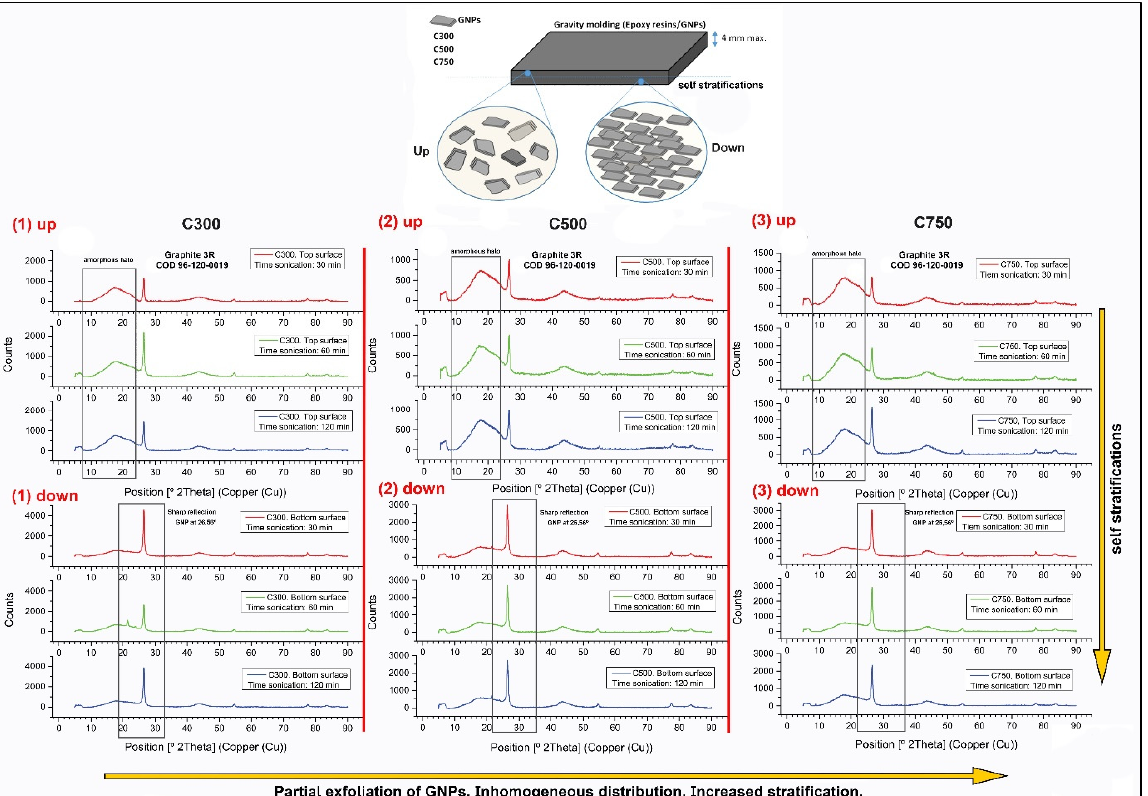
Figure 3. XRD diffraction pattern of GNP/epoxy composites. The spectra obtained are plotted according to the type of graphene used, C300 (1), C500 (2), and C750 (3), according to the surface analysed, that is, up or down, and according to the sonication time of the sample, that is, 30 (red- upper), 60 (green-middle) or 120 min